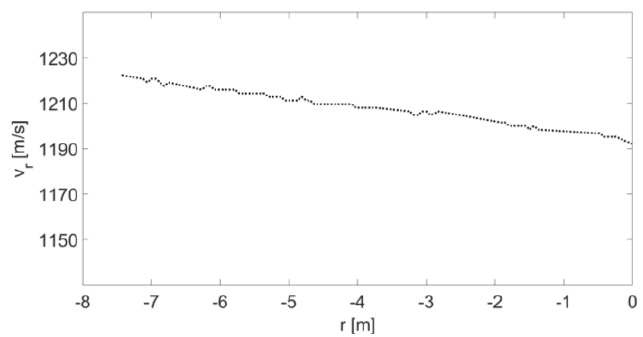
Figure 8. Instantaneous velocity of a small object as dependent on r .